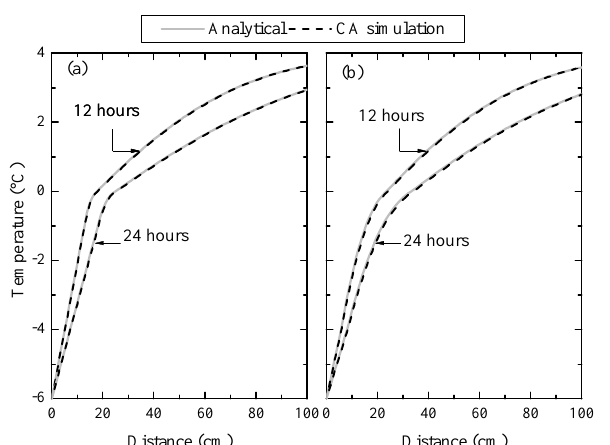
Figure 7. Comparison between analytical solution of heat flow with phase change (Lunardini, 1985) and coupled CA model so- lutions for heat transfer with phase change. Lunardini’s (1985) so- lution is shown and compared with the CA simulation for two cases: (a) T m = − 1 ◦ C and (b) T m = − 4 ◦ C (Table 3, Fig. 6).